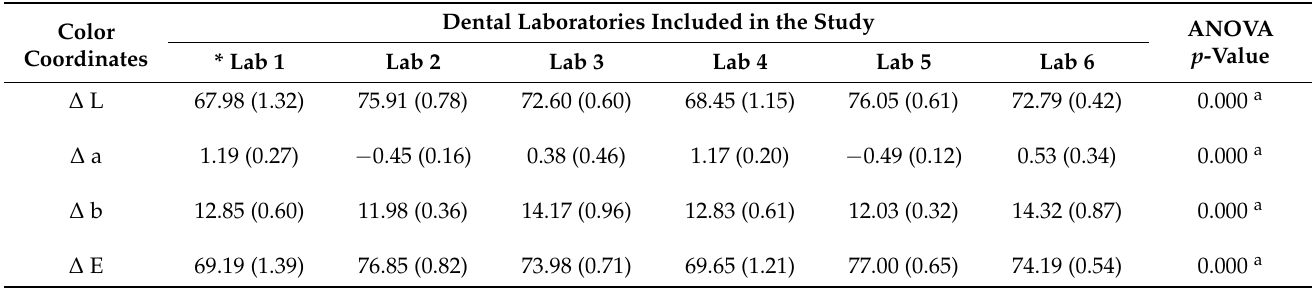
Table 1. Mean values, standard deviations, and ANOVA results of the color coordinates for shade A1.